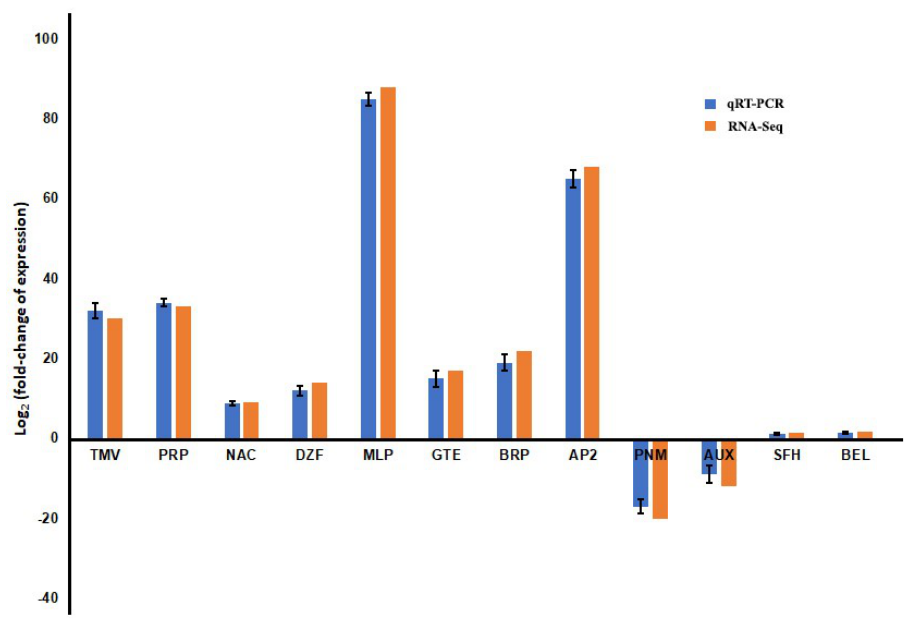
Figure 6. Quantitative real-time PCR (qRT-PCR) validation of differentially expressed genes from RNA sequencing. qRT-PCR analyses were normalized using GAPDH as an internal control gene. TMV: TMV resistance protein; PRP: Pathogenesis-related protein 1; NAC: NAC transcription